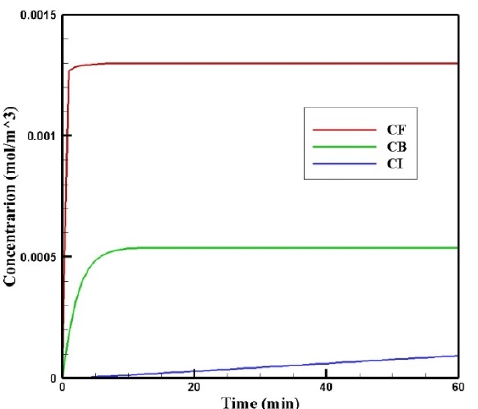
Figure 6. Mean concentrations of the free drug (C F ), bound drug (C B ), and internalized drug (C I ) versus time during 60 min of conventional IPC.